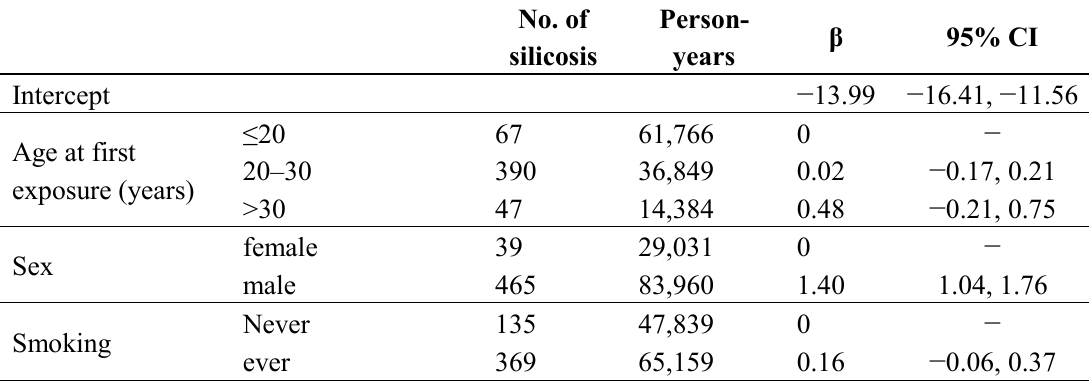
Table 4. Results of Poisson-regression analysis based on respirable crystalline silica dust